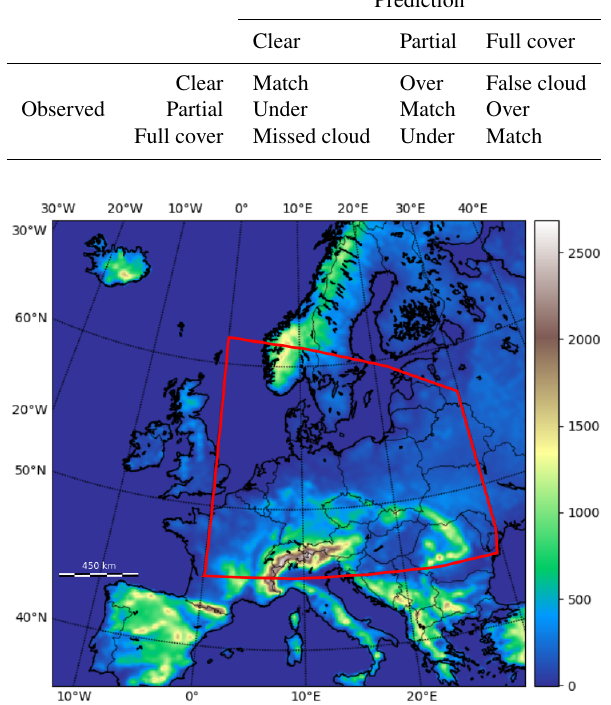
Figure 2. The topography of the target domain, the European do- main, for the simulation. The red line indicates the area for validat- ing the result with cloud cover from the